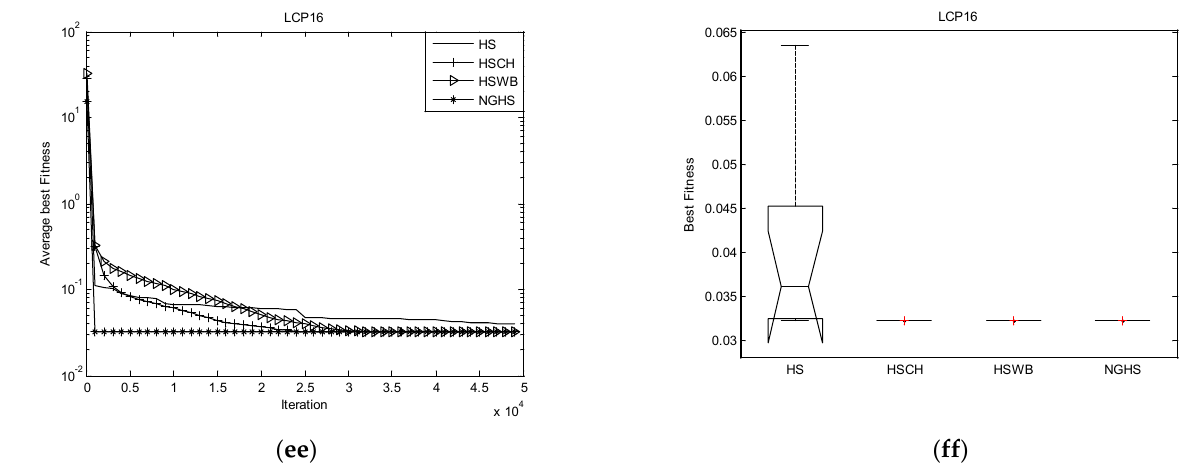
Figure 3. Convergence of mean fitness and boxplot of final best fitness for given LCPs. Table 1. Results for 10 runs on given LCPs.